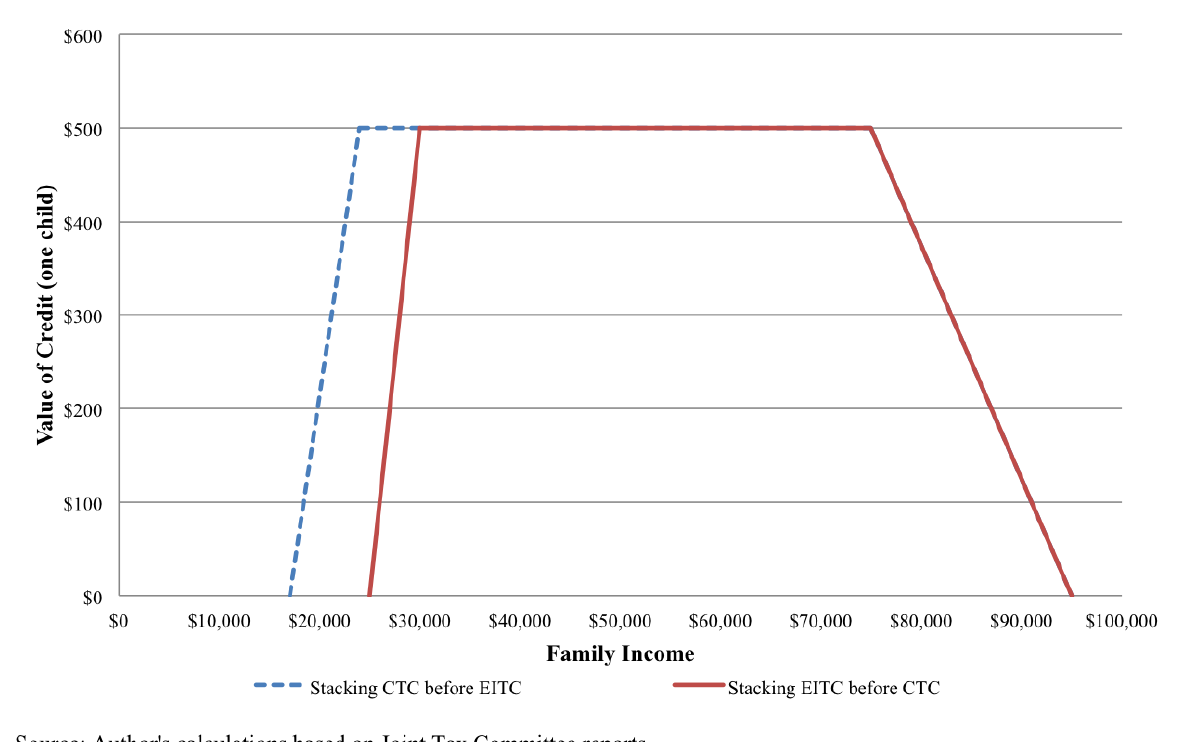
Figure 2: Tax credit eligibility under each stacking